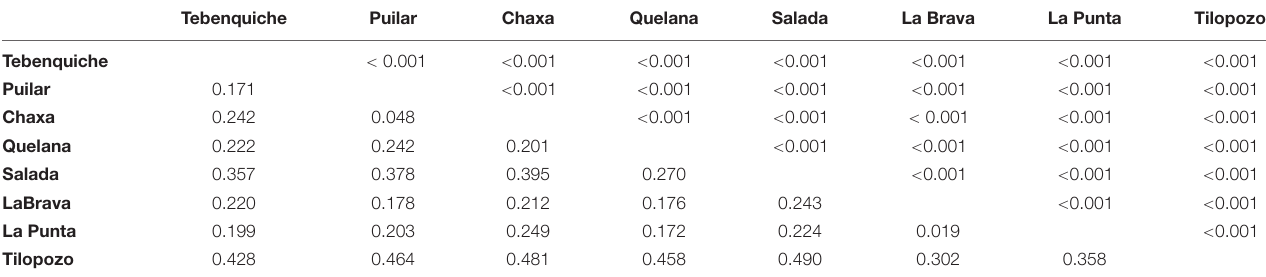
TABLE 3 | Genetic structuring among populations of the Atacama Saltpan obtained using 11 microsatellite loci.